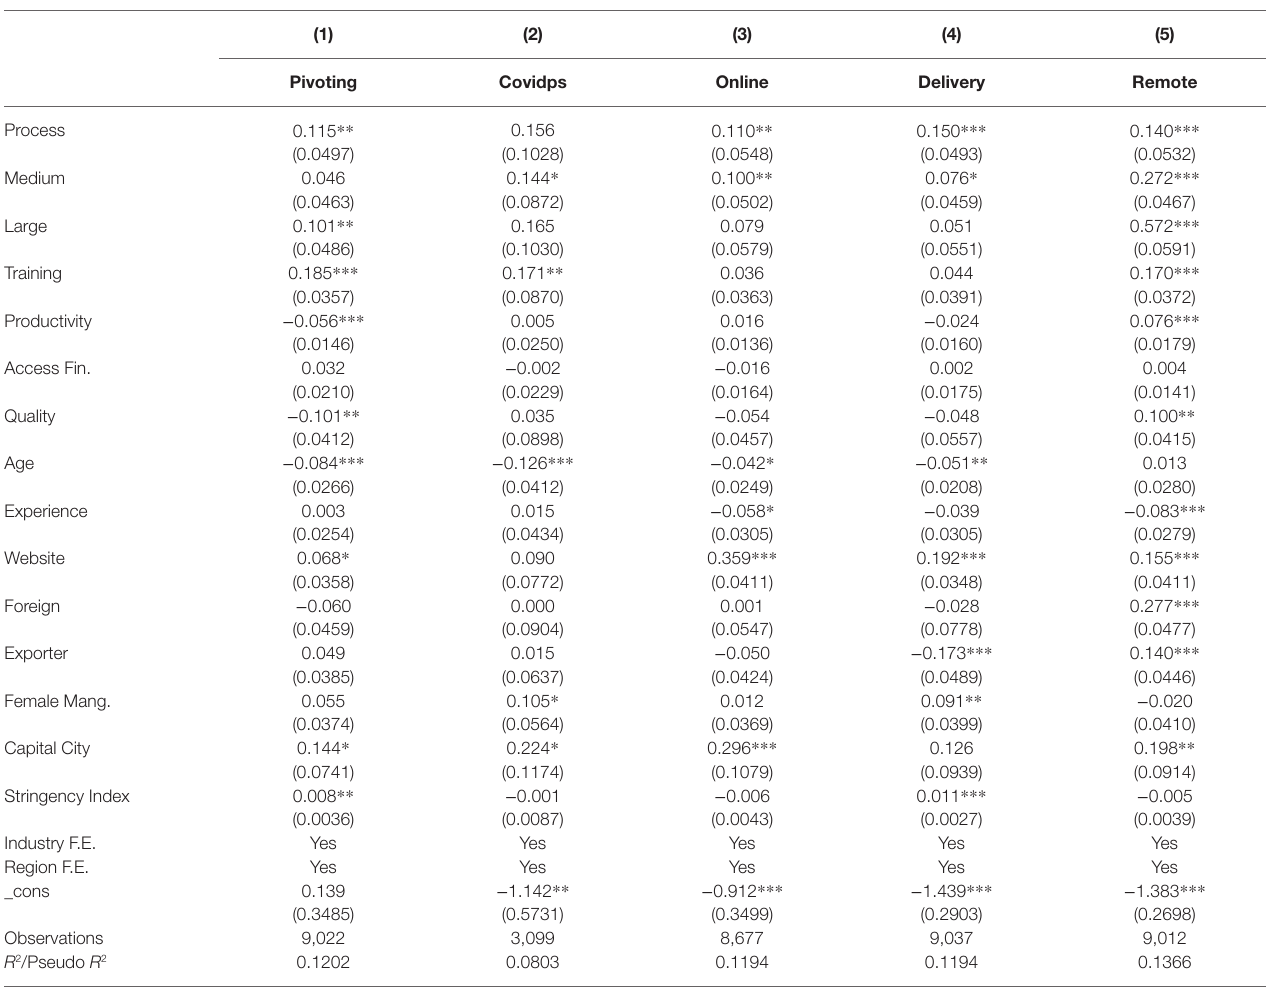
TABLE 5 | Process innovation and